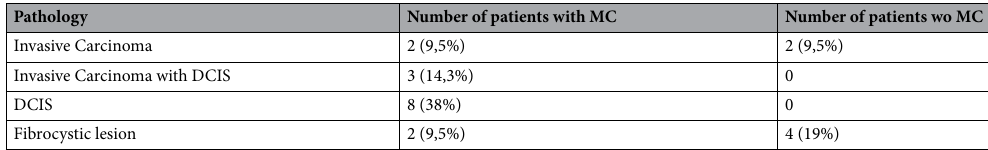
Table 1. Frequency of pathologic diagnoses in mammography in our study collective ( DCIS ductal carcinoma in situ, MC microcalcifications, wo without).